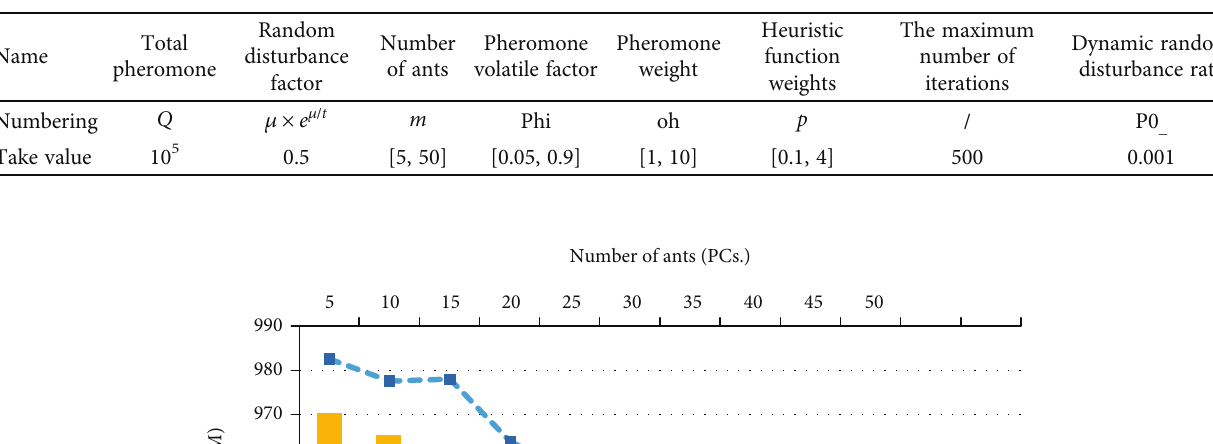
Table 1: Parameters of ACO.